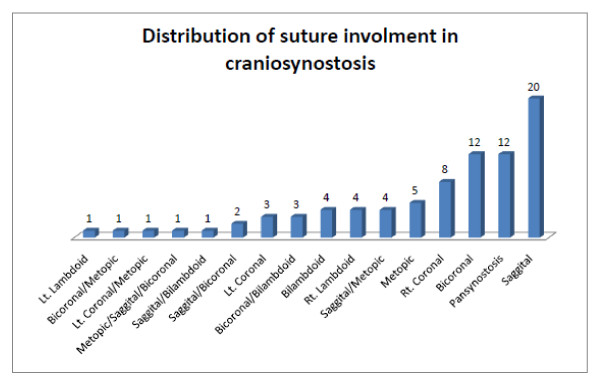
Total number of each category of suture involved in the different types of craniosynostosis is shown at the top of each bar; coronal and sagittal suture synostoses were predominant in our series.